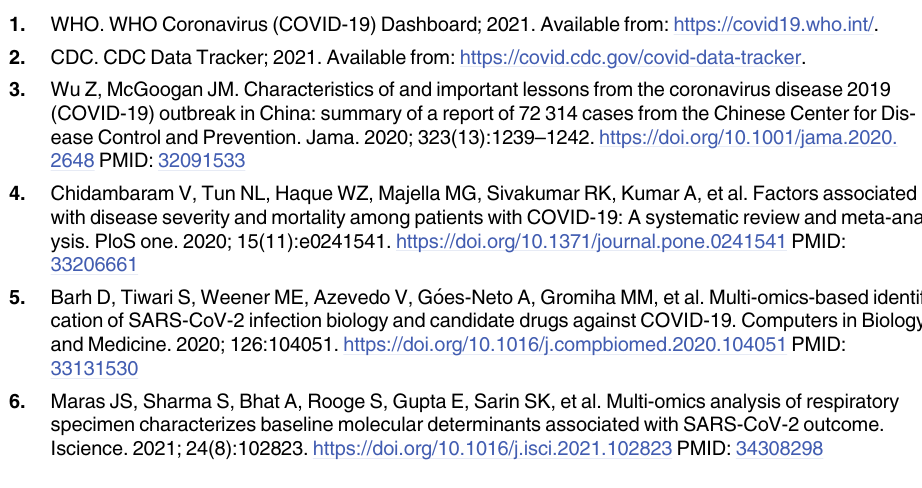
S2 Fig. MS2 fragment match spectrum of high confidence peptides from immunoglobulin heavy constant gamma 4 (A0A286YFJ8). Seven high confidence peptides with 413 PSM (pep- tide spectra matches) were found using QE, only four exemplar peptides are shown in this fig- ure. (TIF) S3 Fig. Trend of different immunoglobulin upon SARS-CoV-2 contamination in patient nasopharyngeal swab samples. a. IgA1, b. IgG1, c. IgG2, d. IgG3, e. IgG4, f. IgM. (TIF) S4 Fig. Interaction of significantly changed genes and their linked pathways. (TIF) S1 File.